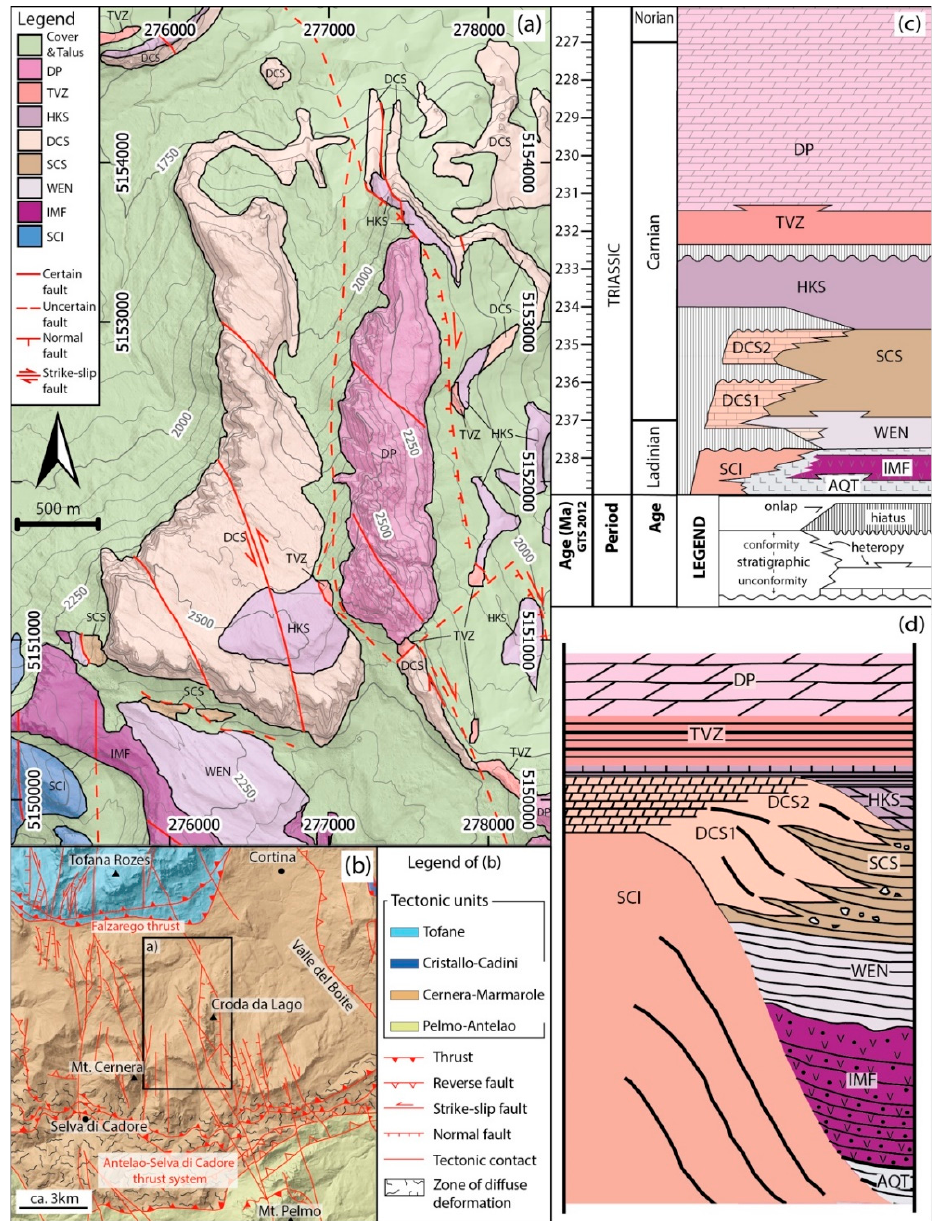
Figure 2. ( a ) Geological map of the study area (modified from [1]). ( b ) Simplified tectonic scheme of the study area and its surroundings (modified from [26]). ( c ) Stratigraphic framework of part of Middle and Upper Triassic of the central-eastern Dolomites (from [29], redrawn). ( d ) Simplified sketch of the stratigraphic relationships in the study area (modified after [1,26]). DP, Dolomia Principale; TVZ, Travenanzes Fm.; HKS, Heiligkreuz Fm.; DCS, Cassian Dolomite (differentiated in DSC1 and DSC2 according to [26]); SCS, San Cassiano Fm.; WEN, Wengen Fm.; SCI, Sciliar Fm.; IMF, Mt. Fernazza Fm.; AQT, Acquatona Fm.; LVN: Livinallongo Fm.